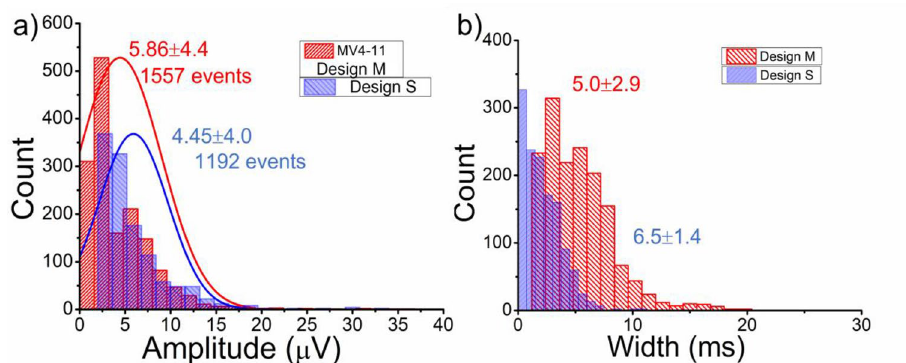
Figure 10. Pulse amplitude and width histograms for standard and modified electrode design (Design S & M) with two colors are shown (the number of events indicated in each case). ( a ) A comparison amplitude histogram plot for Leukemia cells passing through Design S and Design M biochips. The amplitude increment in the mean value for the presented design is observed at 300 kHz input voltage frequency, ( b ) Comparative histogram for pulses width indicates reduction compared to Design S due to the small detection